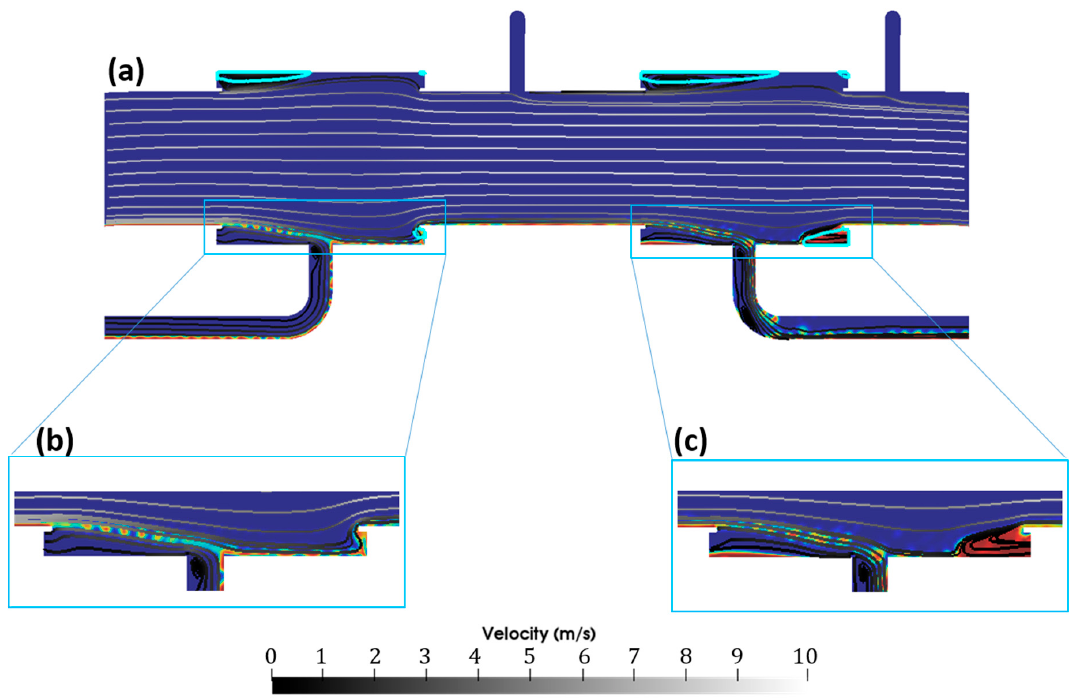
Figure 8. Instantaneous velocity streamlines for case 2 (i.e. U G = 7.7 m/s ) . The background indicates the liquid (red) and gas (blue). The contour line maps locations flow separation. ( a ) View of both separators and main pipeline in an xy slice at the center (z-direction) of the geometry. ( b ) View of the rightmost, bottom part of the first separator unit. ( c ) View of the rightmost, bottom part of the second separator unit.